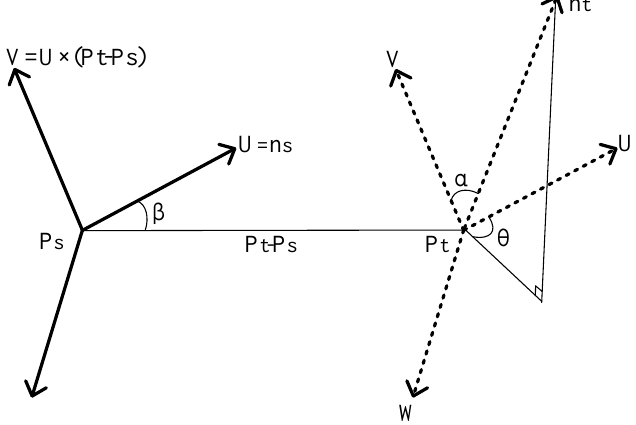
Figure 1. The relationship between a point pair P s and P t .